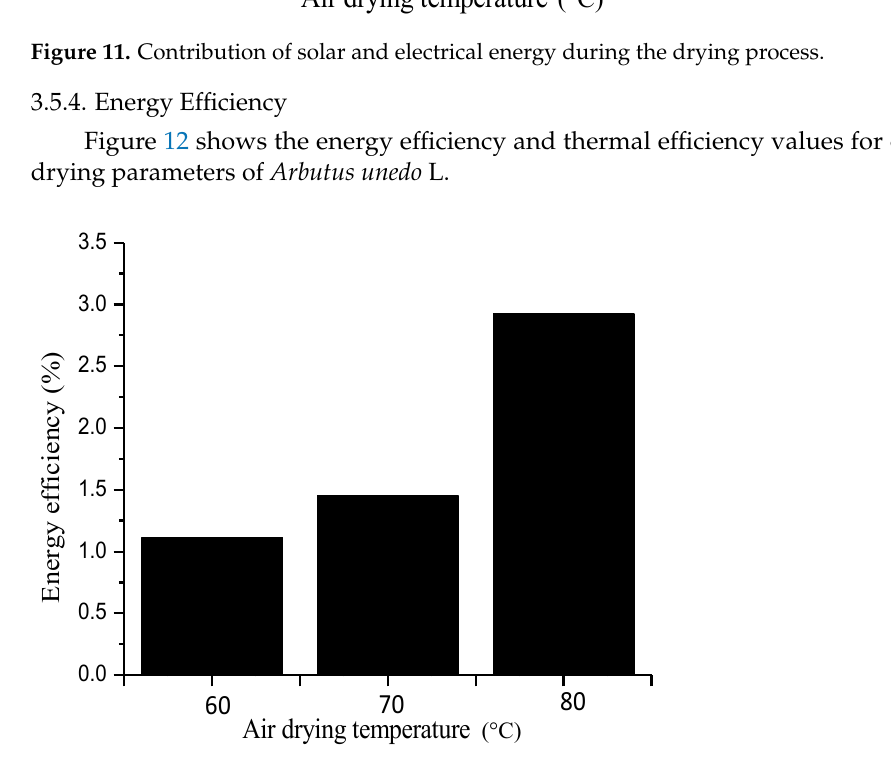
Figure 12. Energy efficiency for drying the Arbutus unedo L. fruits at different air ‐ drying tempera ‐ tures.